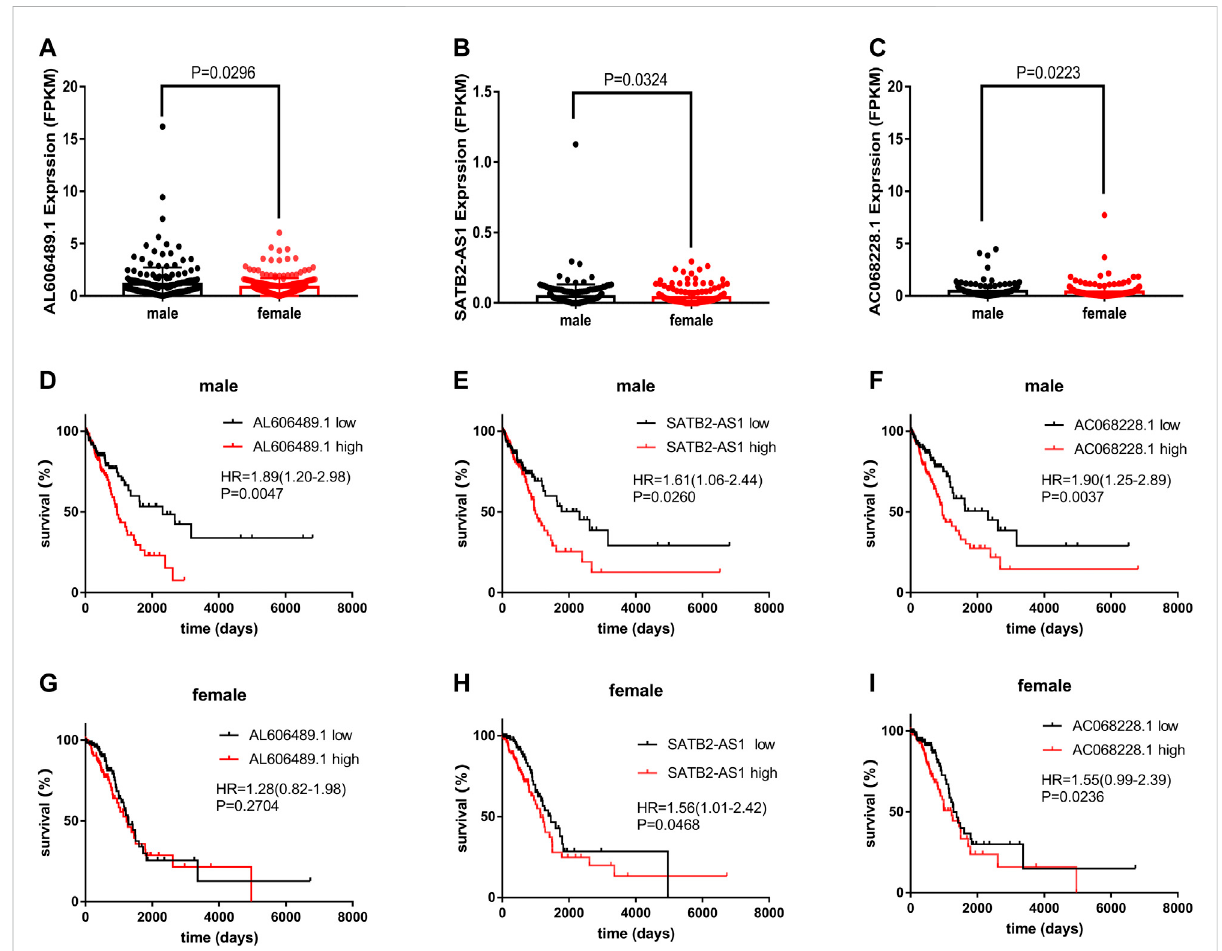
FIGURE 7 The expression of AL606489.1, SATB2-AS1 and AC068228.1 in LUAD. (A) Differentially expressed AL606489.1 between 260 female and 219 male tumor samples. (B) Differentially expressed SATB2-AS1 between 260 female and 219 male tumor samples. (C) Differentially expressed AC068228.1 between 260 female and 219 male tumor samples. Kaplan – Meier curves for OS associated with the AL606489.1 expression in (D) male and (G) female. Kaplan – Meier curves for OS associated with the SATB2-AS1 expression in (E) male and (H) female. Kaplan – Meier curves for OS associated with the AC068228.1 expression in (F) male and (I)